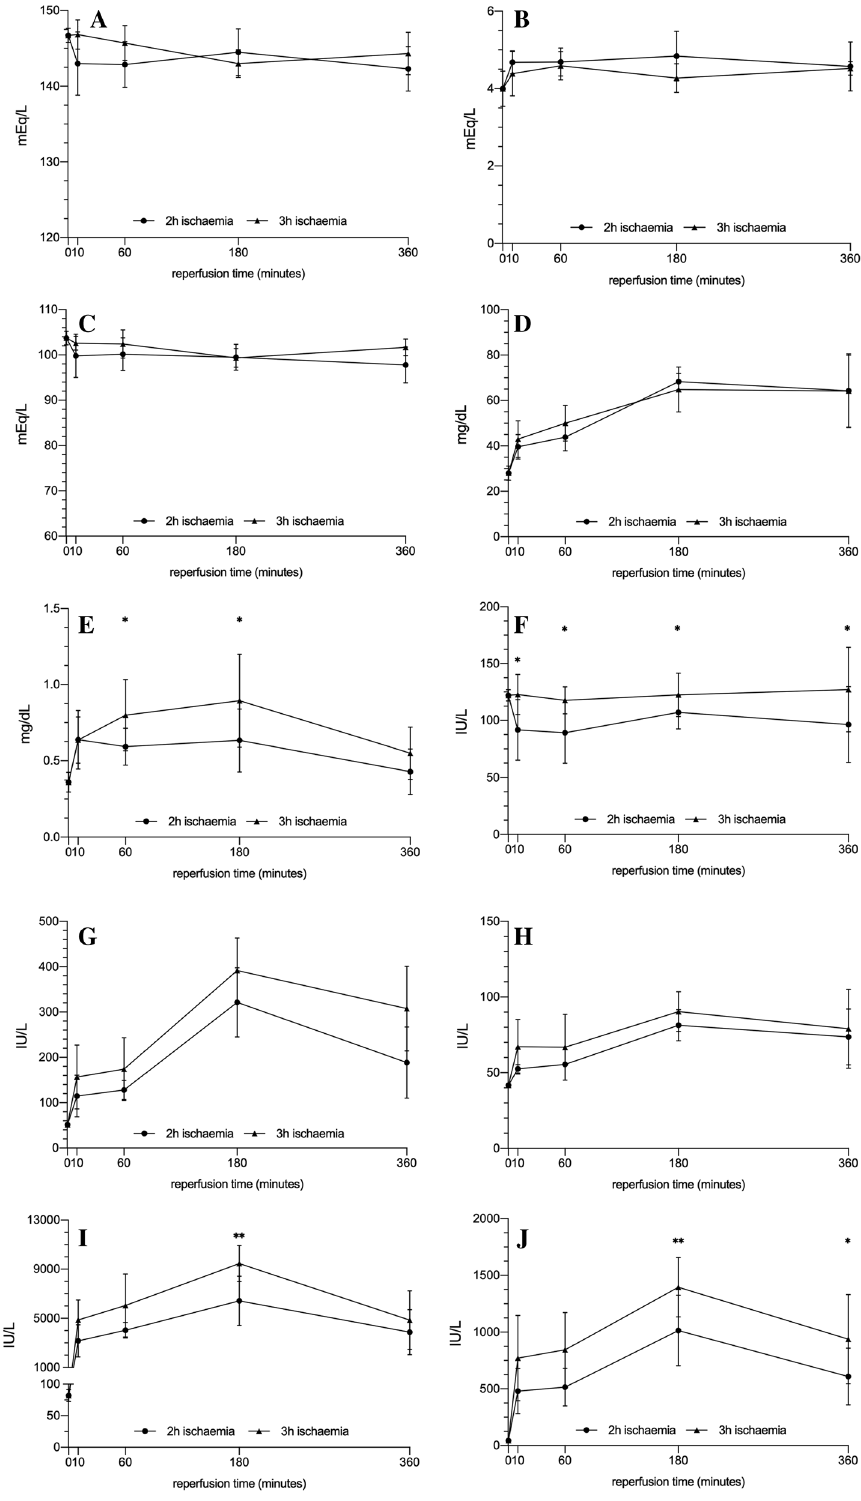
Figure 2. Measurements of serum electrolytes and enzymes of animals exposed to 2 h (circles, solid line) or 3 h (triangles, dashed lines) of ischemia and different periods of reperfusion. Na + ( A ), K + ( B ), Cl− ( C ), urea ( D ), creatinine ( E ), ALP ( F ), AST ( G ), ALT ( H ), CK ( I ) and LDH ( J ). Units are milliequivalents per litre (mEq/L) for Na + , K + and Cl − , mg/dL for urea and creatinine, and international units per litre (U/L) for ALP, AST, ALT, CK, and LDH. The asterisks indicate statistically significant differences when comparing the two durations of ischemia (2 or 3 h) in each reperfusion period analysed; *(p < 0.05), **(p < 0.01). ALP alkaline phosphatase, AST aspartate aminotransferase, ALT alanine aminotransferase, CK creatine kinase, LDH lactate